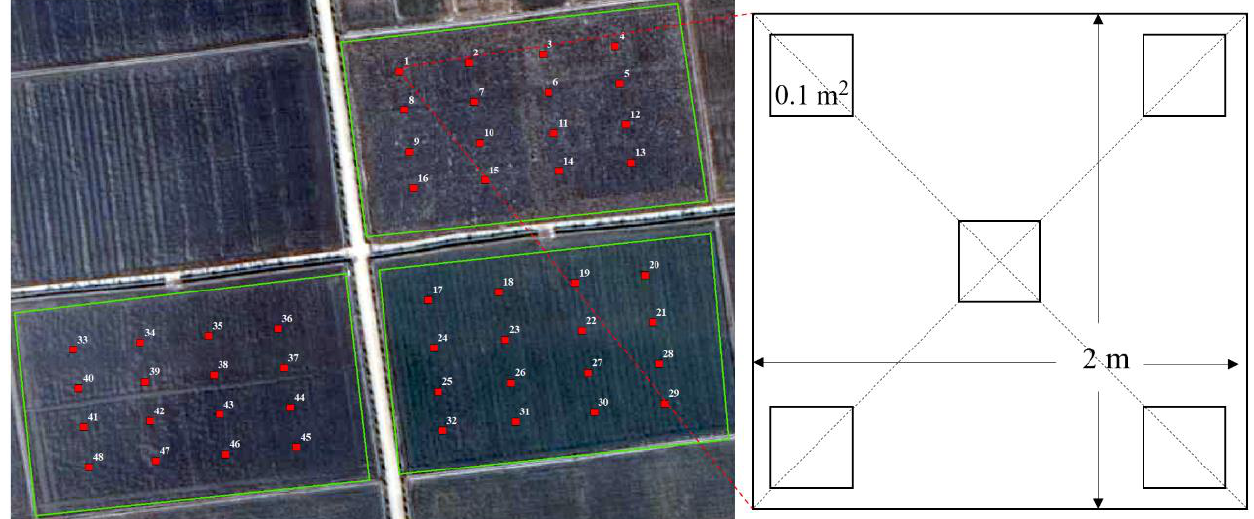
Figure 3. Location of georeferenced sampling plots in the field and five-point sampling method.